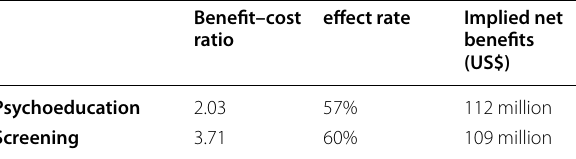
Table 5 Evaluation of the economic impact of suicide prevention